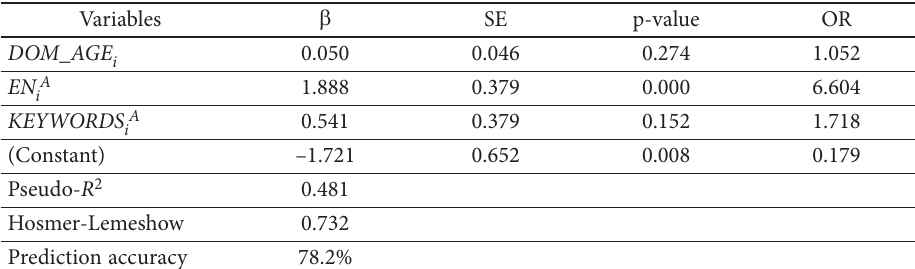
Table 10. Prediction of export orientation with automatically retrieved WWW